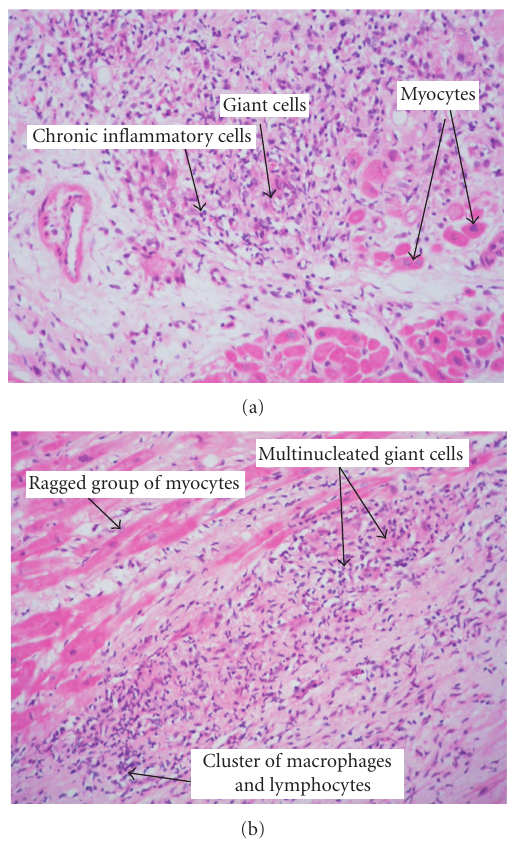
Figure 2: Histology samples from endomyocardial biopsy. Biopsy showing active chronic inflammation with macrophages and giant cells. High-power view of granulomatous focus of myocardial biopsy. Note ill-defined granulomas di ff erentiating it from TB, sarcoidosis, and so